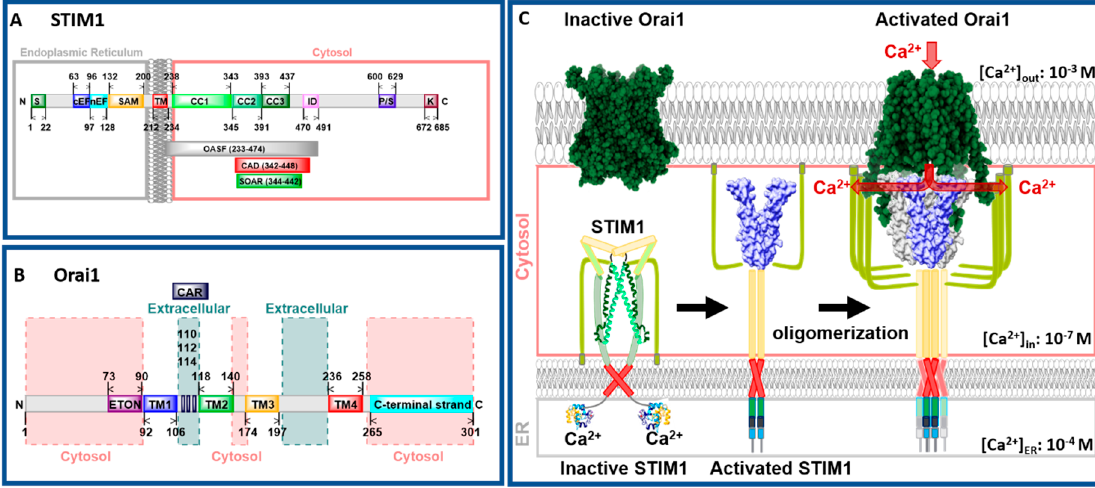
Figure 1. Stromal interaction molecule 1 (STIM1) and Orai1. ( A ) Scheme showing full-length human STIM1 with respect to regions critical for the regulation of the STIM1/Orai1 signaling cascade. Important minimal STIM1 C-terminal fragments, such as OASF (Orai1-activating small fragment), CAD (Ca 2+ release-activated Ca 2+ channel (CRAC) activation domain) and SOAR (STIM1–Orai1-activating region) are further represented as insets. ( B ) The scheme shows the full-length human Orai1 channel with highlighted regions and residues that are crucial for the Orai1 function. ( C ) The scheme visualizes STIM1 and Orai1 in the resting state (left) and STIM1 extended state established upon store depletion at ER–PM junctions (middle) . STIM1 punctae formation, that is achieved via oligomerization, is followed by STIM1 binding to the Orai1 C-terminus, which presumably extends ~45 Å into the cytosol (right) .